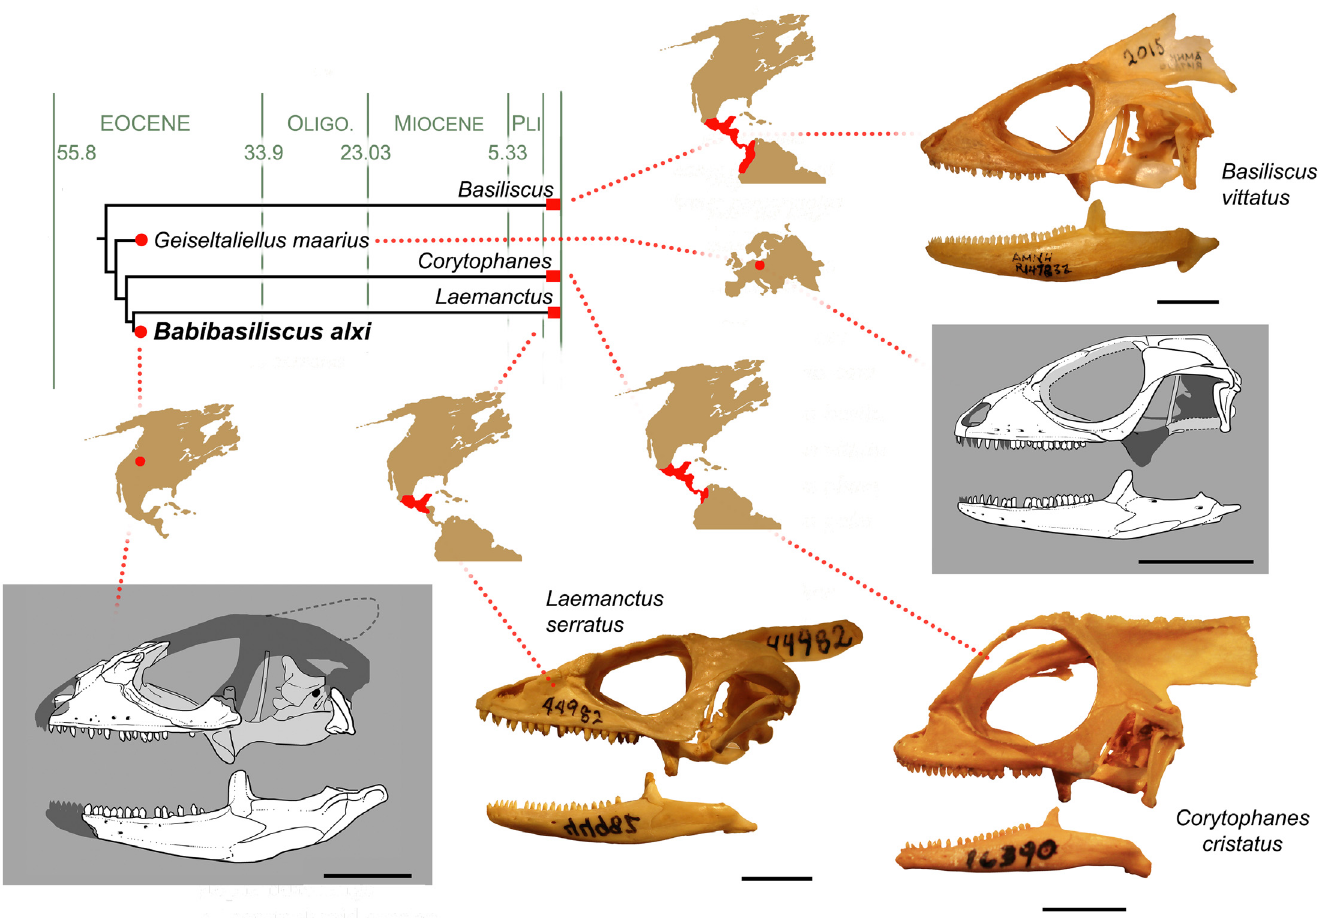
Fig 7. Phylogeny of corytophanids and distribution of anoles, para-anoles, corytophanids, and some malarial infection. (A) Time-calibrated phylogeny of the corytophanid genera with representative illustrations of their skull